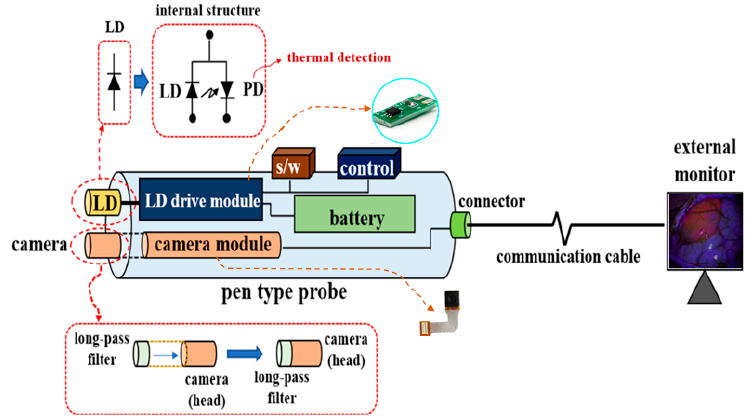
Figure 2. Detailed structure of a proposed pen-type probe.